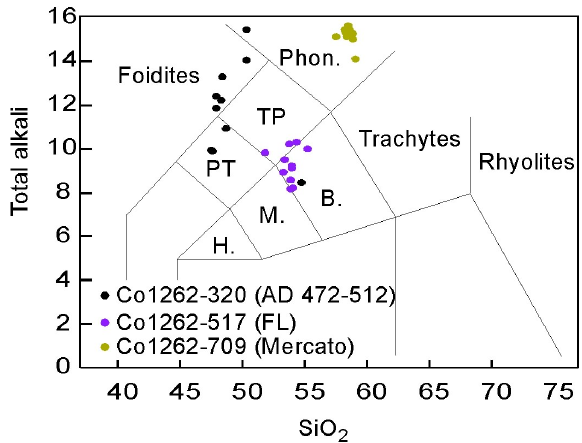
Fig. 6. Classification of tephras and cryptotephras recognised in core Co1262 from Lake Ohrid by means of the total alkali vs. silica diagram (TAS, Le Bas et al., 1986). The raw data of tephras and cryptotephras is given in Table